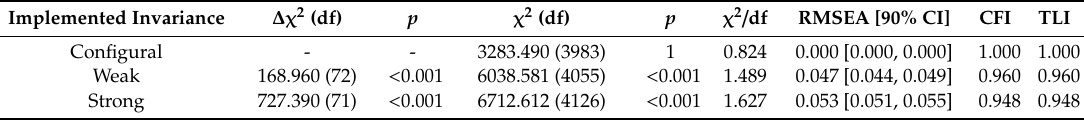
Table 2. Model fit and comparisons of the configural, weak, and strong invariant ability-CFA. Implemented Invariance